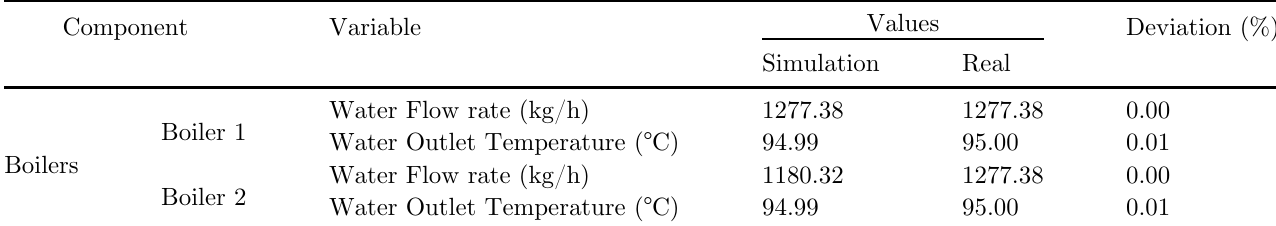
Table 4. Simulation results and validation